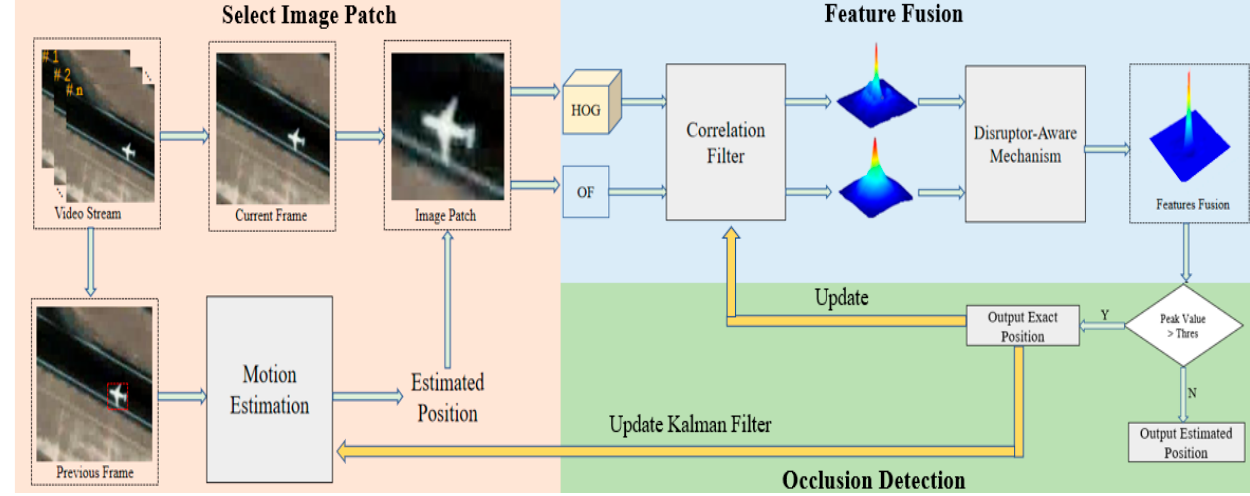
Figure 2. Flowchart of our algorithm.